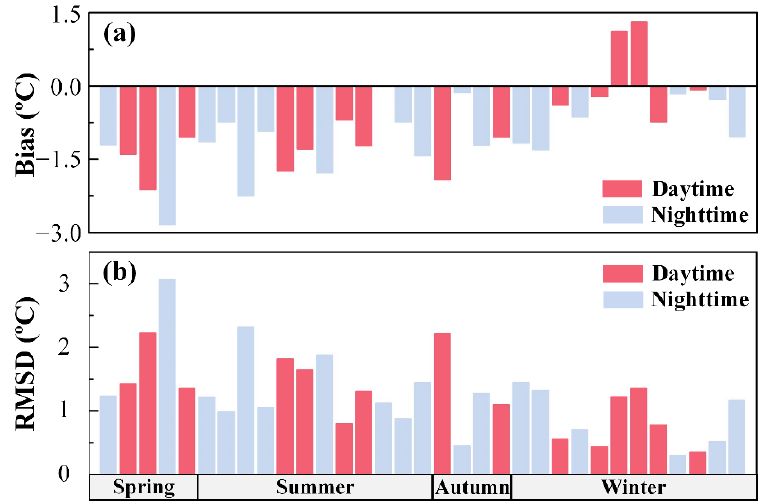
Figure 6. ( a ) Bias and ( b ) RMSD of ECOSTRESS SST against MODIS SST in FB between August 2018 and August 2020 for each season. Data are color-coded in red for daytime and blue for nighttime.